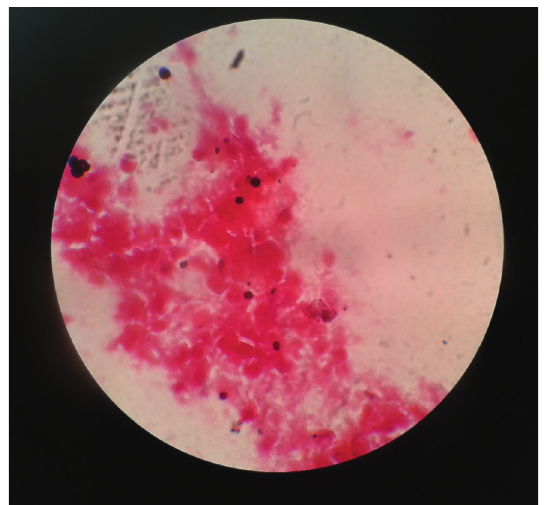
Figure 1: Gram staining revealing plenty of pus cells with fungal spores (Conidia) but lacking bacteria, when observed under a 100X Olympus CX21 compound microscope.